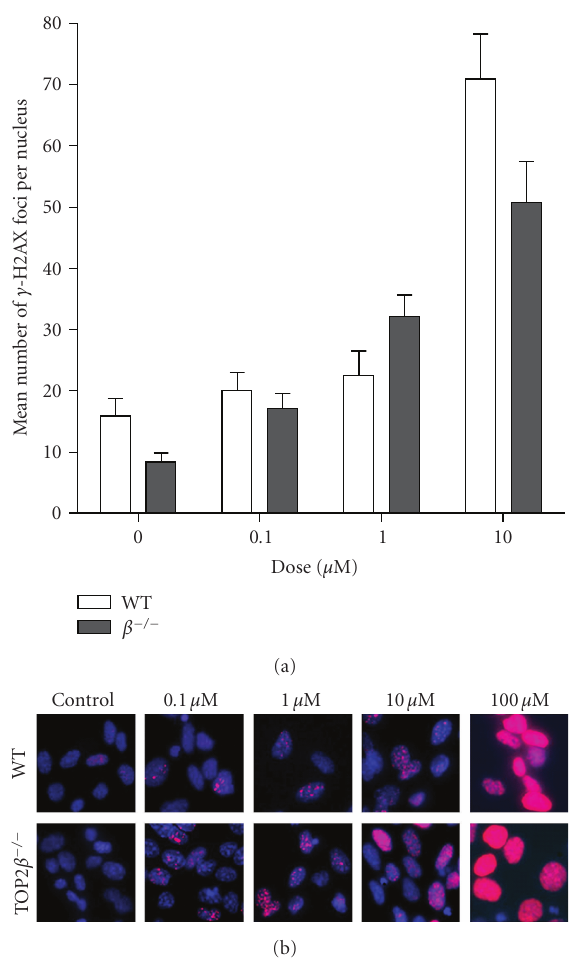
Figure 2: γ H2AX foci formed in response to increasing doses of etoposide. WT and TOP2 β − / − MEFs were exposed to 0.1, 1, 10, and 100 μ M etoposide for 2 hours and then assayed for γ H2AX foci. (a) Histograms of foci number ± SEM at each dose counted. 100 μ M was not counted as foci were not distinct at this dose. Data derived from one experiment. (b) Representative images of γ H2AX foci (red) in nuclei stained with DAPI (blue) in WT and TOP2 β − / − MEFs.